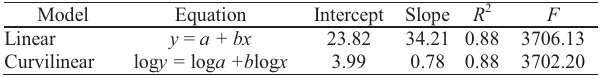
Table 1. Regression analysis for the relationship between spine diameter and observed fork length for bigeye tuna, T. obesus